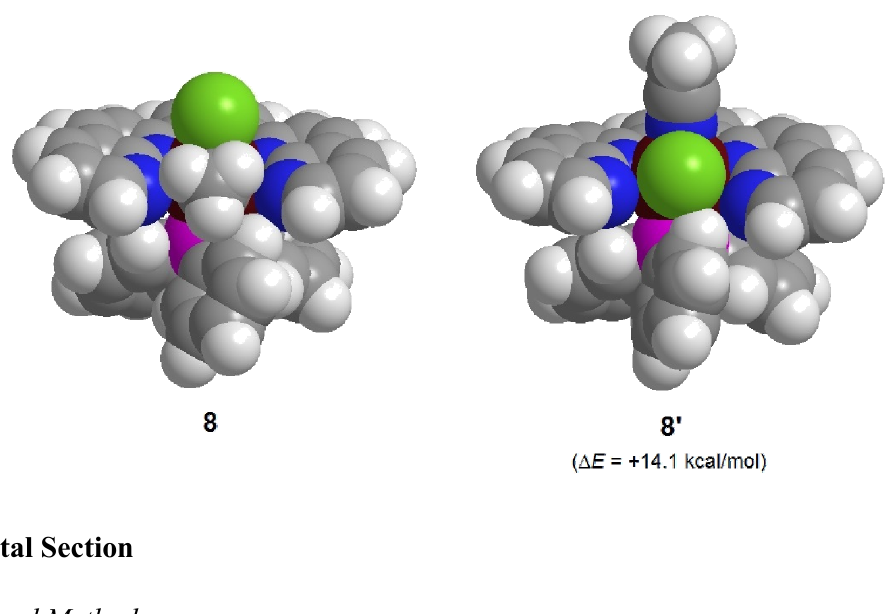
Figure 6. Space-filling models of the lowest energy structures of geometrical isomers ( 8 and 8 ′ ) with the electronic energy